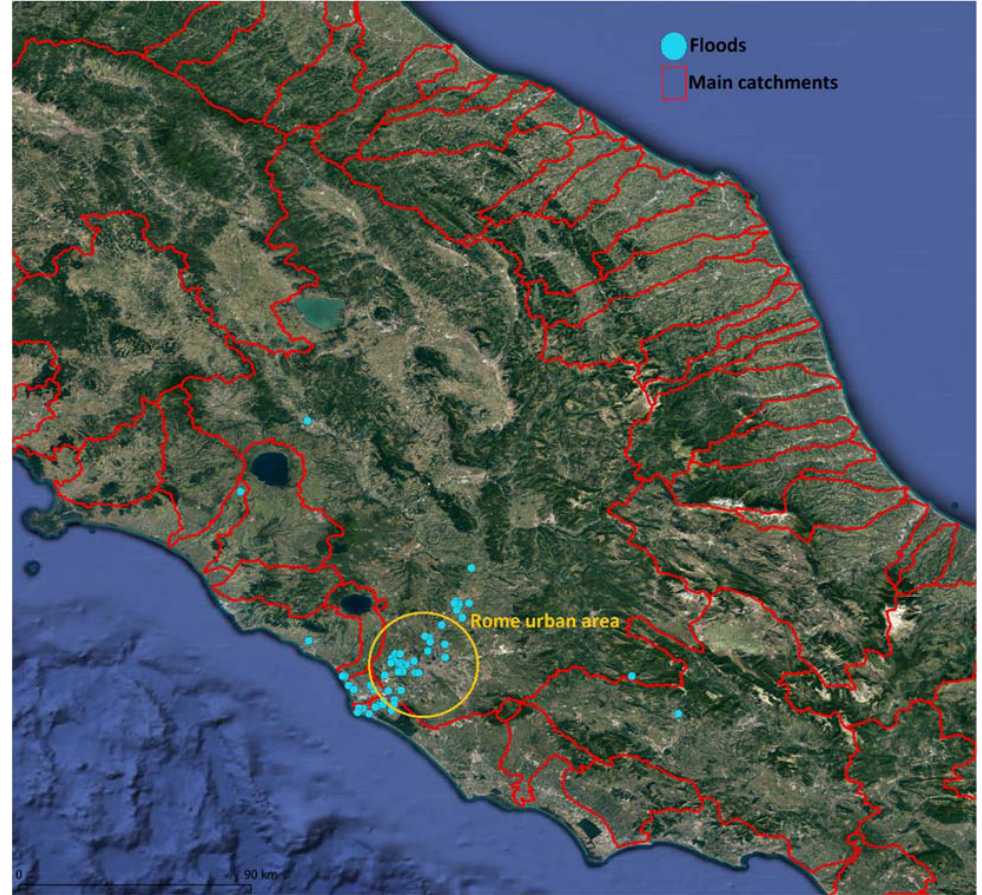
Figure 2. Location of flood events (cyan circles) reported during the event in the Lazio Region Civil Protection Report and press releases. The yellow circle indicates the urban area of Rome. For a better localization of each phenomenon, the file named “Domain.kmz” for the visualization on GoogleEarth© is provided in the Supplementary Material